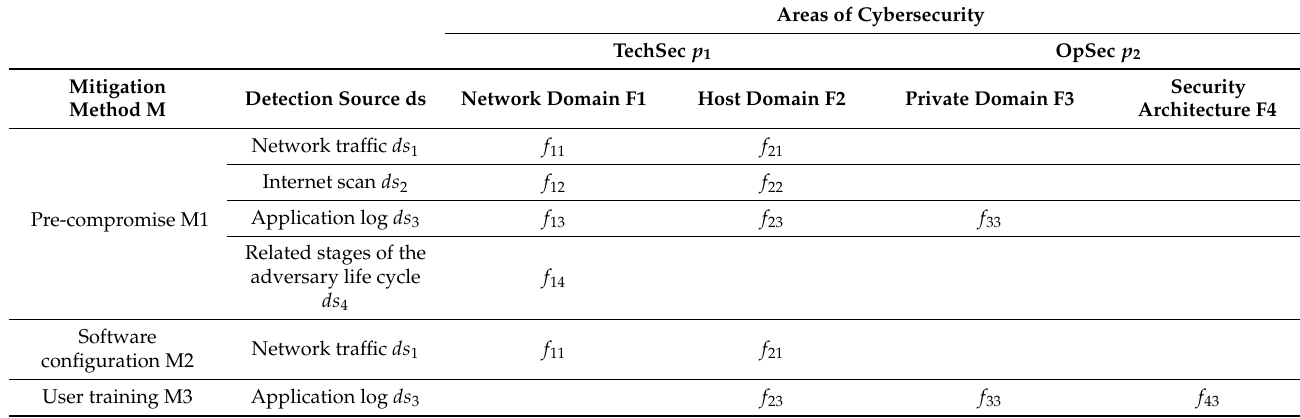
Table 1. Stage 1: Reconnaissance.